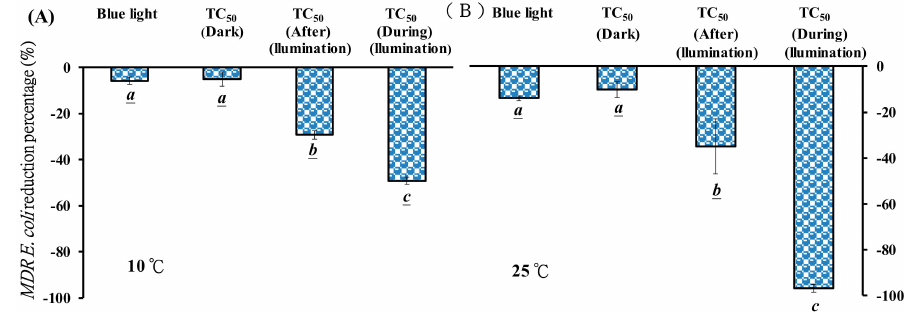
Figure 7. ( A ) Effects of photolysis product of TC (PPT) and TC under blue light illumination treatment on MDR E. coli viability at 10 ± 1 ◦ C. ( B ) Effects of PPT and TC, under blue light illumination treatment, on MDR E. coli viability, with 25 ± 3 ◦ C. 50 mg/L TC in the dark used as a control. The reduction of MDR E. coli was treated with PPT (after illumination treatment) and with a photochemical reaction process treated with 50 mg/L TC under blue light illumination at 2.0 mW/cm 2 for 120 min (during illumination treatment). Data are represented by mean ± SD, where n = 3. Statistical differences ( p < 0.05) between the groups are indicated by the different letters below each